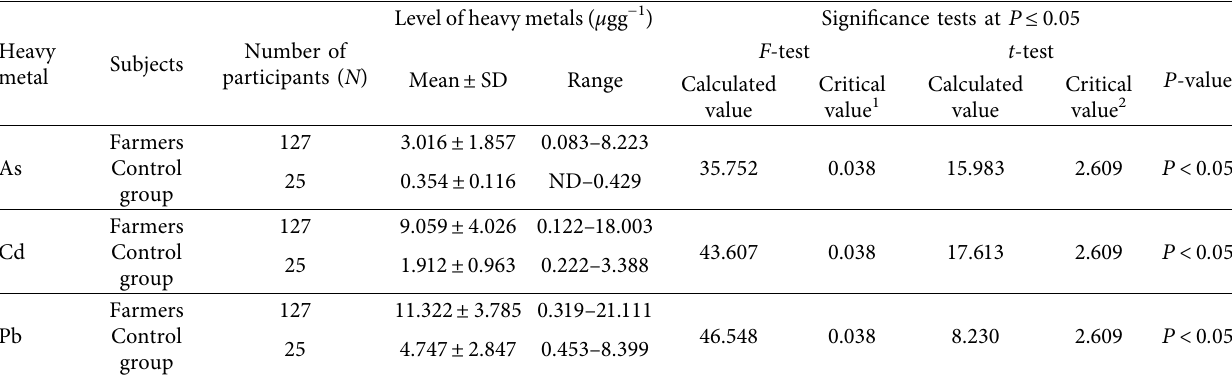
Table 5: Concentration levels of heavy metals in fingernails samples of the participating farmers and the control group.